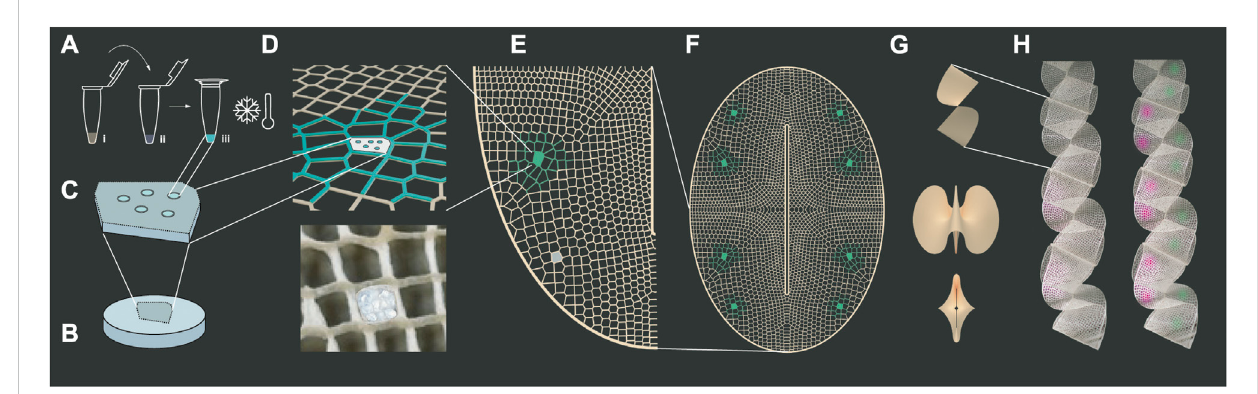
FIGURE 1 Multiscale Design for Bio-interactive Systems. Microscale design: (A) Cell-free reactions of commercial TXTL are added to biopolymers in diverse concentrationsandfreezedriedtotesttheirexpressionaftersimplerehydration:(i)TXTL,Mastermix,andDNAcomposingtheexpressionkit(ii)silk fi broin orsodiumalginatebiopolymer,(iii)lyophilization. (B) Biopolymer blenddisksaremadebylyophilization asmechanicalsupporttohostcell-freereactions in “ A ” .Mesoscaledesign: (C) Con fi gurationsofpebells “ A ” areencrustedinto “ B ” toformbiosites. (D) Thesearemechanicallypress- fi ttedintospeci fi c cells within additively manufactured 50 cm-long fi brous biopolymer lattices. (E) Certain lattice areas are conferred with higher sparsity and porosity to supportbiositeperformance. Macroscaledesign: (F) Anovalwithalongitudinalslitischosenas (G) a2d-to3dfoldingmodularshapeabletoconforminto ribbons. (H) Ribbons are distributed as indoor surfaces or partitions and envisioned as air-interactive devices in our future